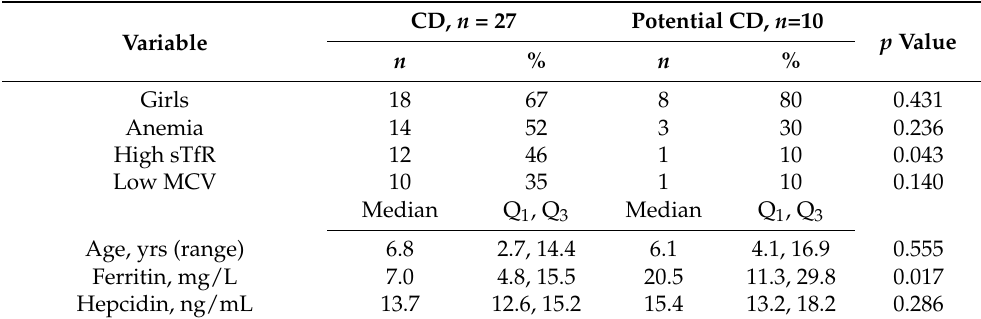
Table 1. Clinical characteristics and laboratory values of 37 children with celiac disease (CD) and potential CD. CD, n = 27 Variable